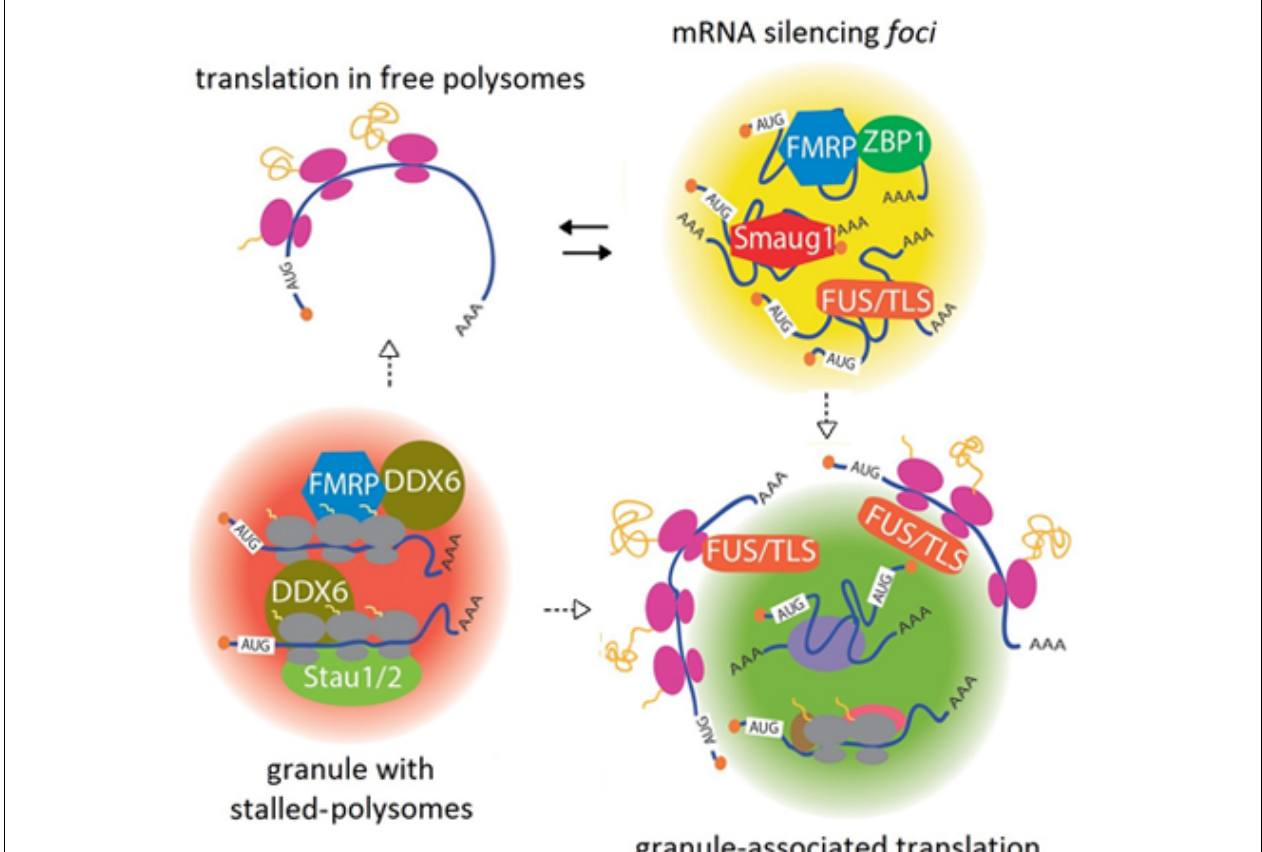
in dendritic granules and stalls polysomes in yeast, is speculated (see the text). DDX6/RCK/p54/Me31B would be recruited through the interaction with FMRP and additional RBPs. Dissolution or restructuration of the granules to release stalling factors would allow translation in either free polysomes or granule-associated polysomes (dotted arrows). Granule-associated translation was demonstrated for ARC/Arg3.1 mRNA and FMRP mRNA and might be a common mechanism that also operates in dendritic PBs. The role of FUS/TLS is speculated from data from non-neuronal cells. Translation would occur in the granule periphery, and this may involve reorganization of the mRNA-silencing foci or stalled polysome